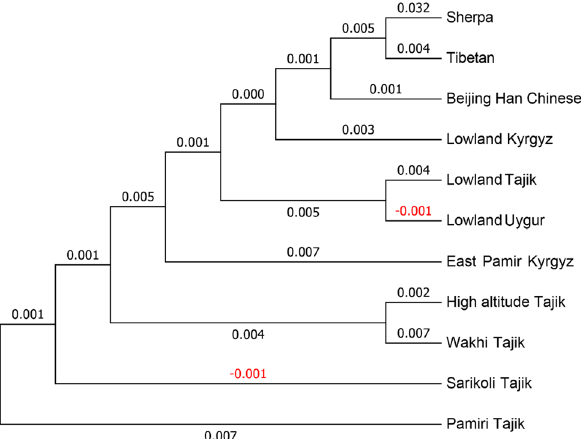
Figure 4. Genetic distance of populations from HA-Tajiks and other ten populations based on mtDNA haplogroup